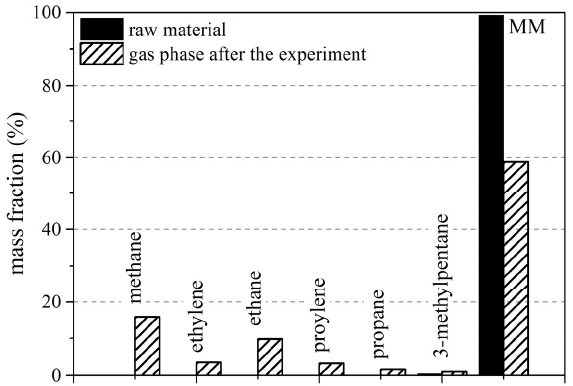
Figure 4. Mass fraction of vapor phase after the experiment and of raw material ( T = 420 °C, t = 72 h, relative error caused by gas chromatograph <2%).